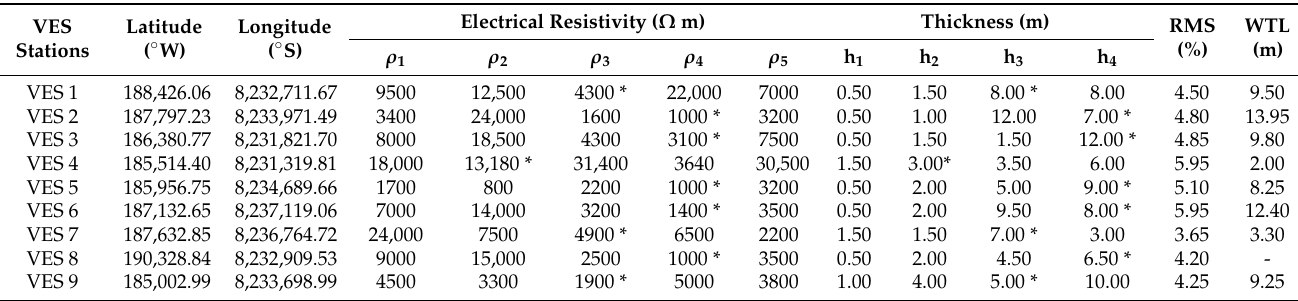
Table 1. Results of the geoelectric model, with mean absolute percentage error (MAPE), and water table level (WTL) in the VES stations of the study